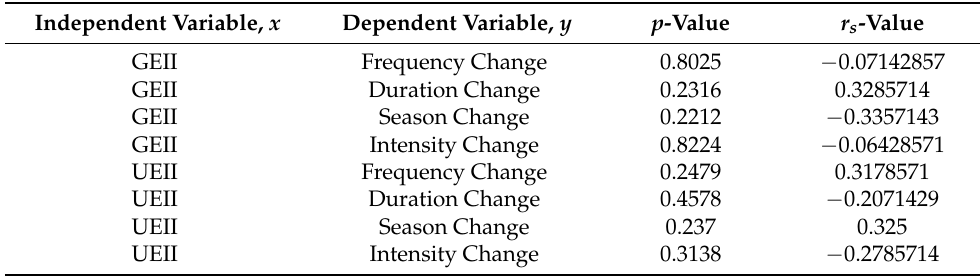
Table 11. Spearman correlation between UEII, GEII, and heatwave frequency, duration, season, and intensity for 15 cities in North Region.